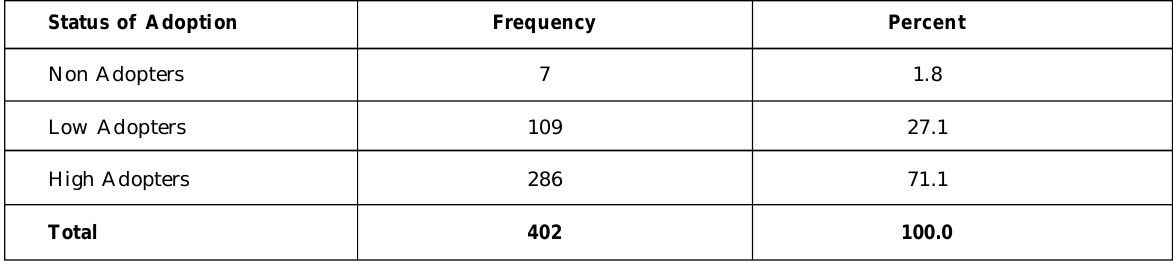
Table 1: Status of adoption of Eco-Friendly Farming Practices by households Status of Adoption Frequency Percent Non Adopters 7 Low Adopters 109 High